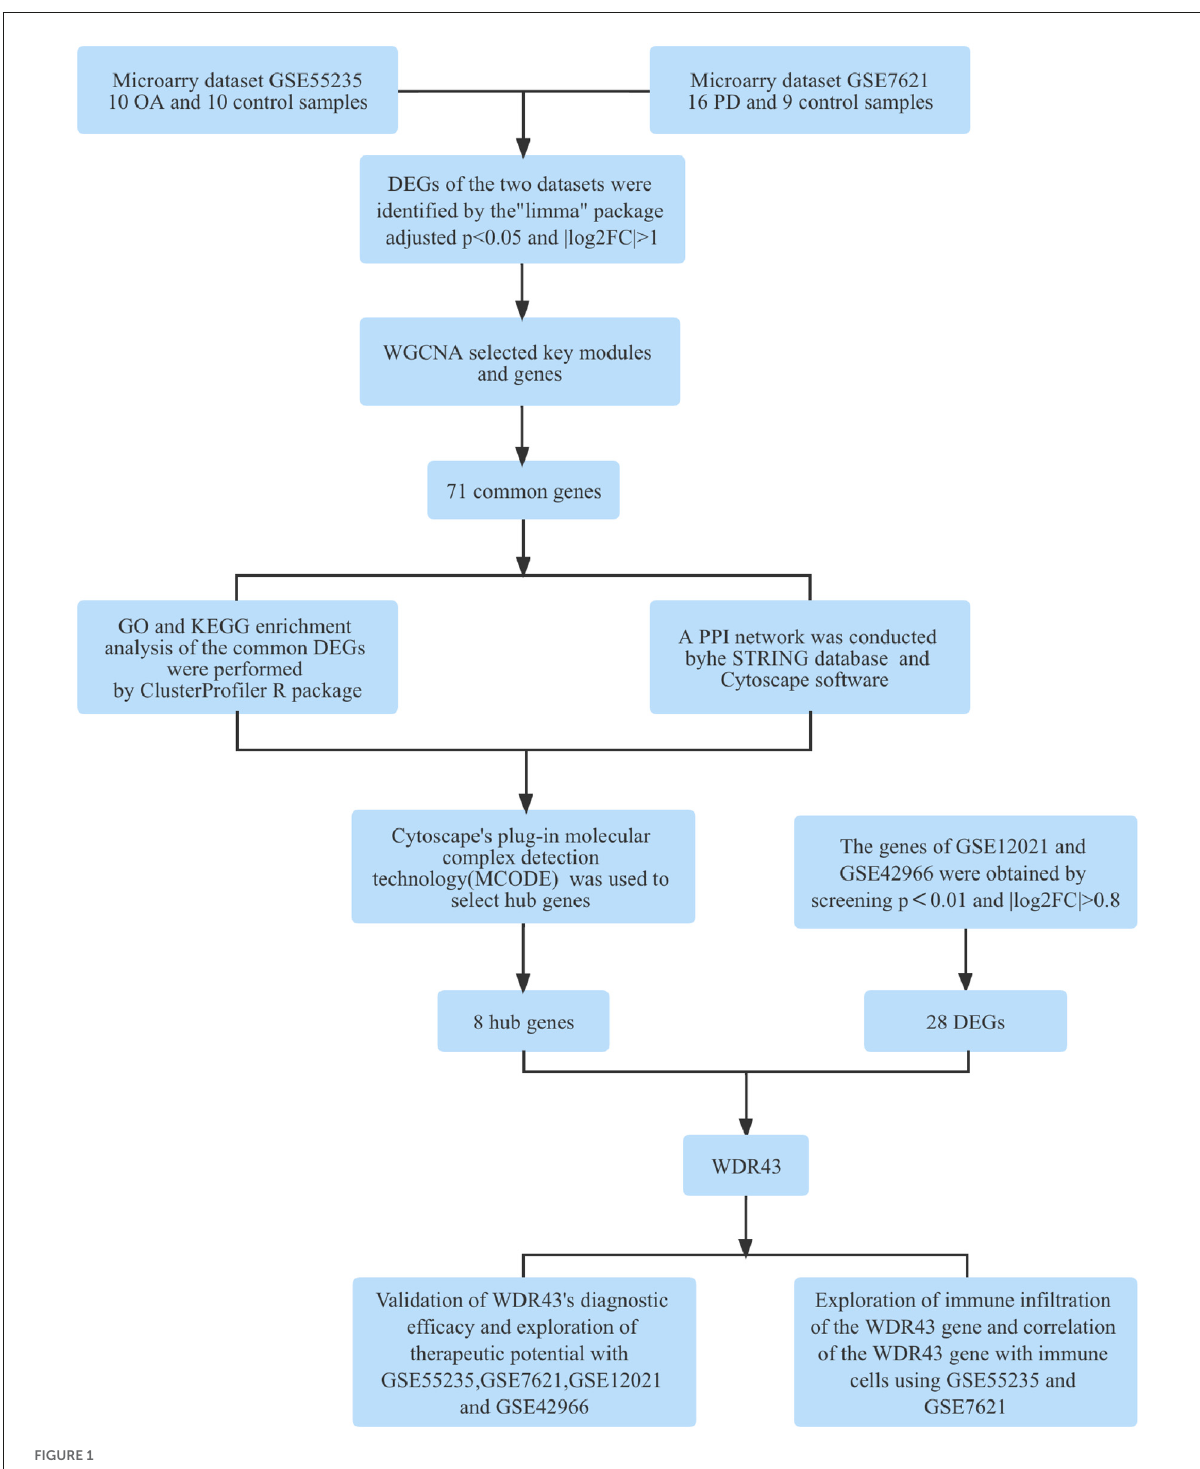
FIGURE1 Research design flow chart.